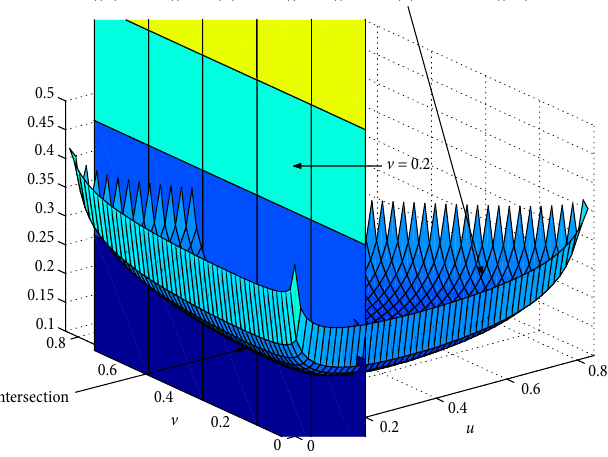
Fig. 1. The intersection between d ( u , v ) and v = 0.2